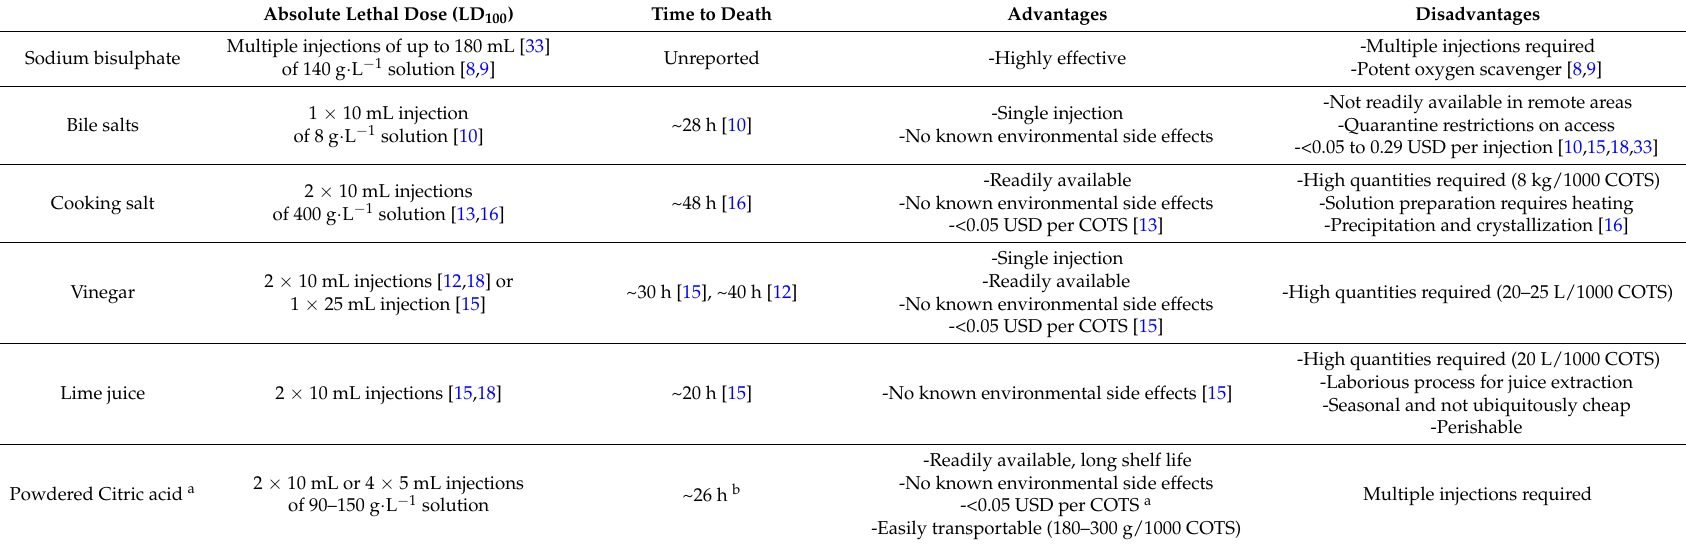
Table 2. Comparison of the chemicals currently available for injections of Acanthaster cf. solaris (crown-of-thorns starfish